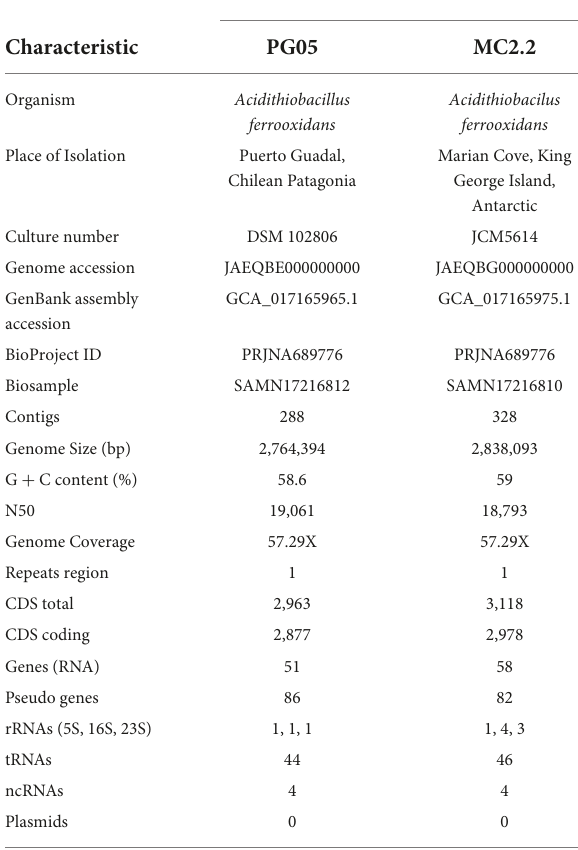
TABLE 4 Genome sequence attributes of Acidithiobacillus strains PG05 and